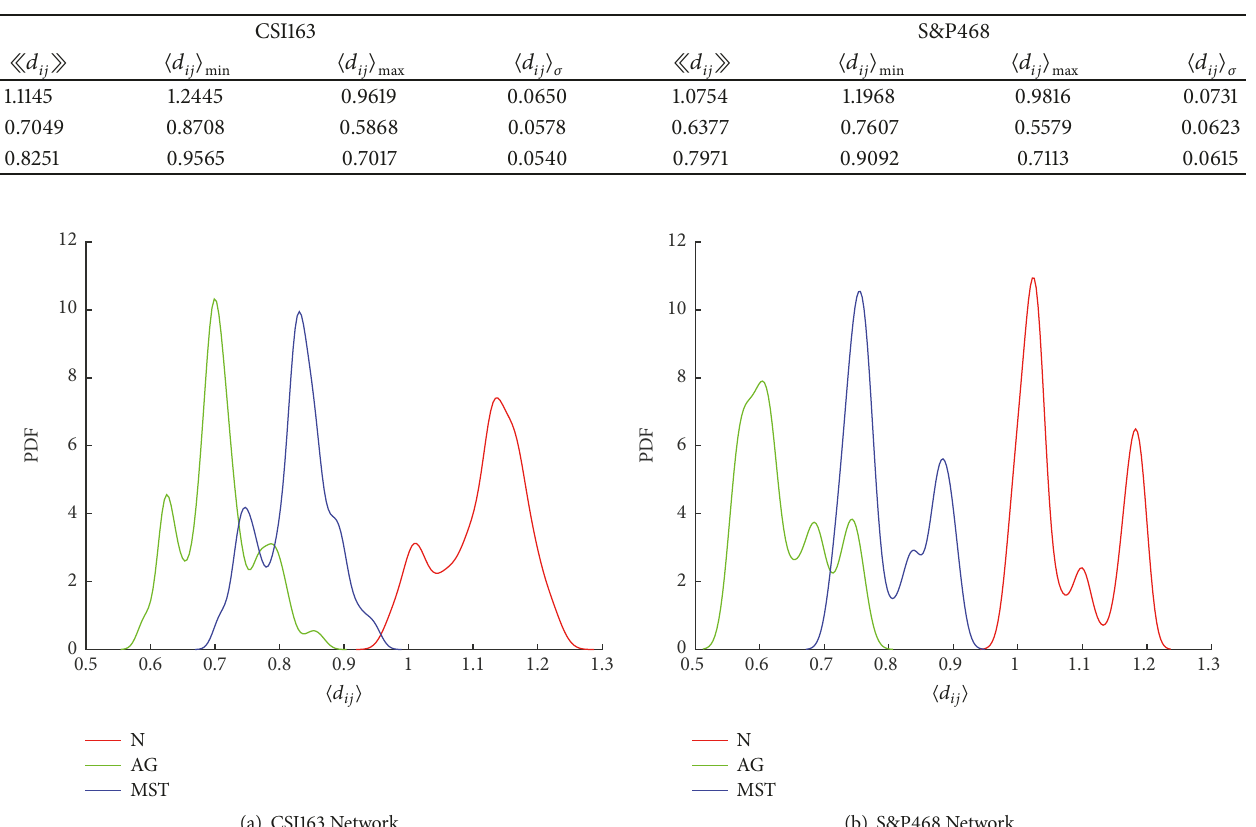
Table 12: Average ( 𝑑 𝑖𝑗 ) , minimum ⟨𝑑 𝑖𝑗 ⟩ min , maximum ⟨𝑑 𝑖𝑗 ⟩ max , and standard deviation ⟨𝑑 𝑖𝑗 ⟩ 𝜎 of CSI163 and S&P468 networks. The values of first row belong to the original network 𝑁 , those of the second row belong to the AG, and those of the third row belong to MST.